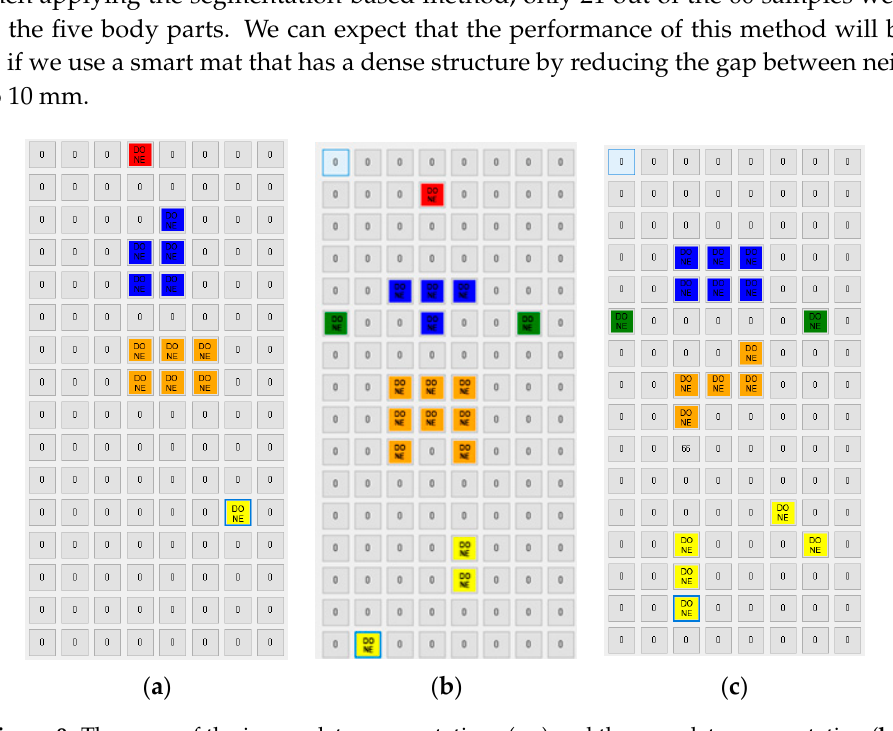
Figure 9. The cases of the incomplete segmentations ( a , c ) and the complete segmentation ( b